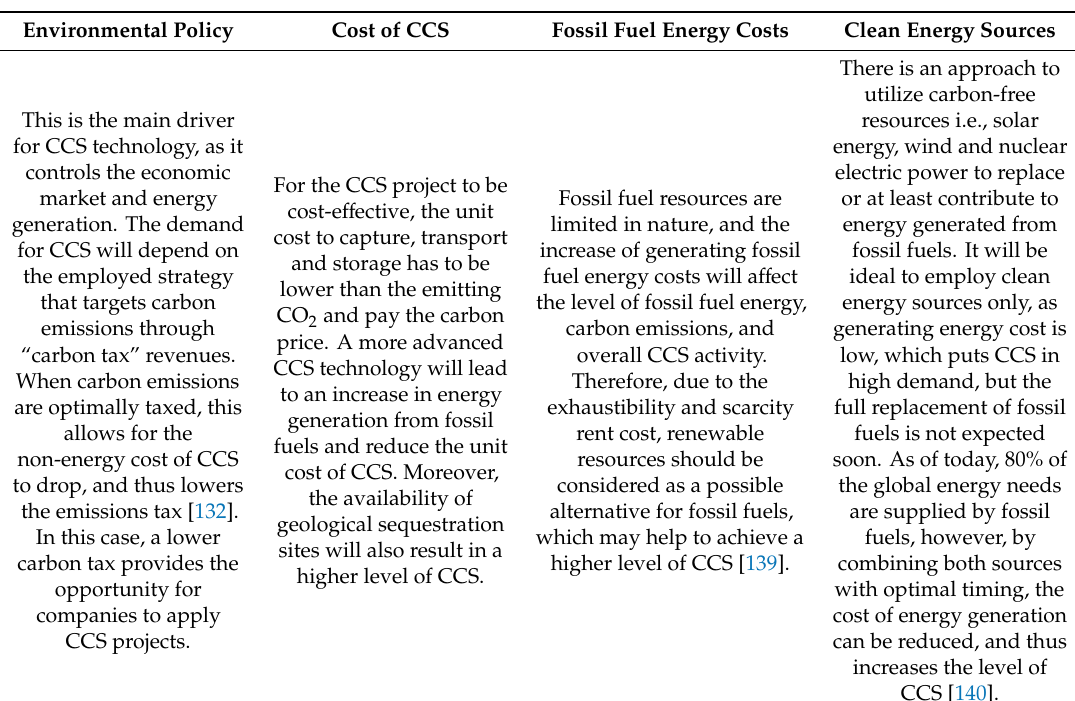
Table 6. Economic drivers for CCS projects